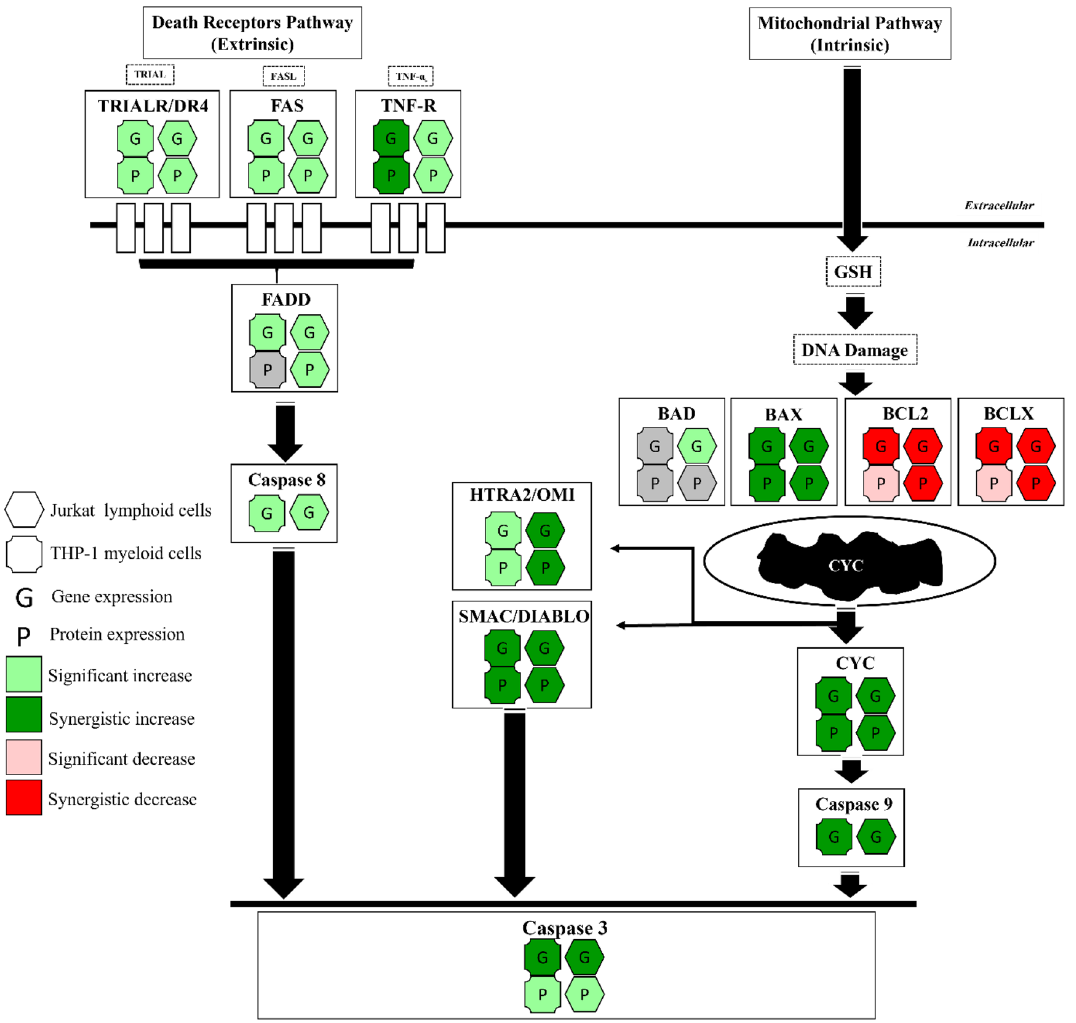
Figure 8. A summary of the effects of apigenin and etoposide combination treatments on apoptosis-related gene and protein expression in acute leukaemia cells (Jurkat and